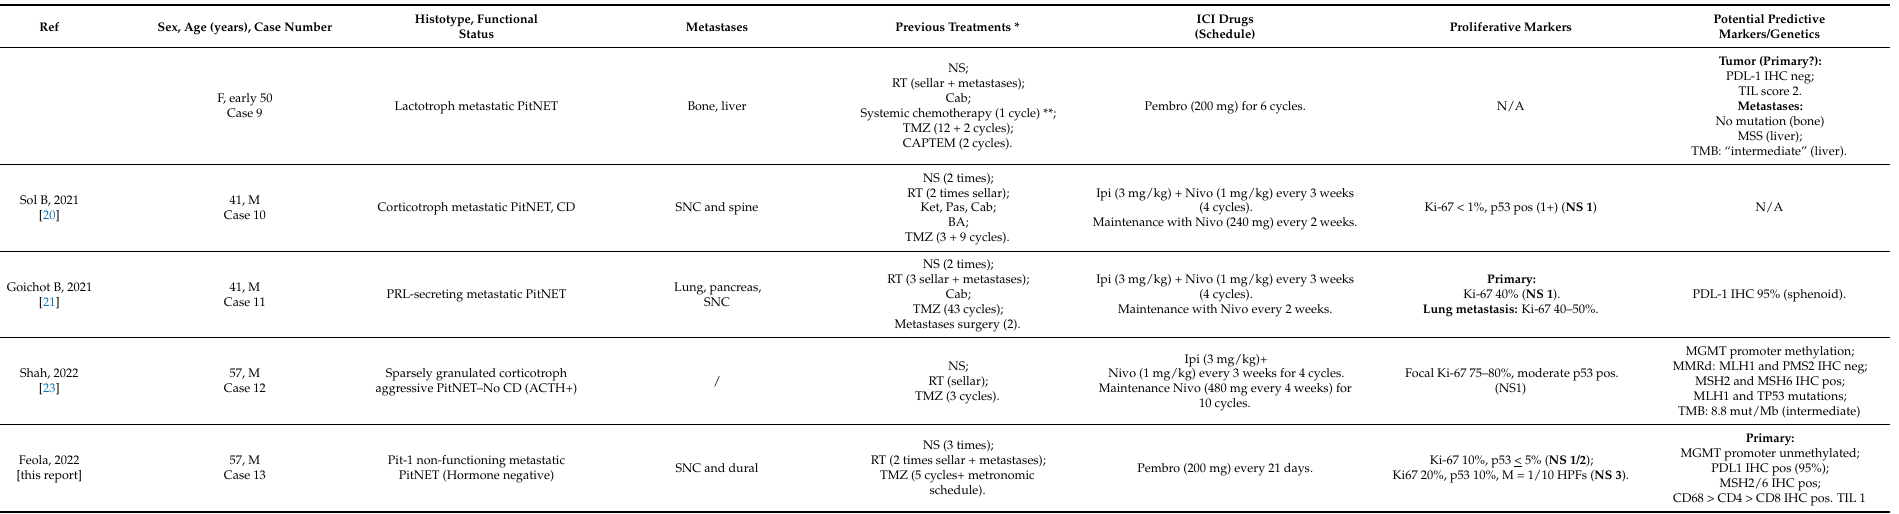
Table 2. Characteristics of aggressive and metastatic PitNETs treated by immune checkpoints inhibitors